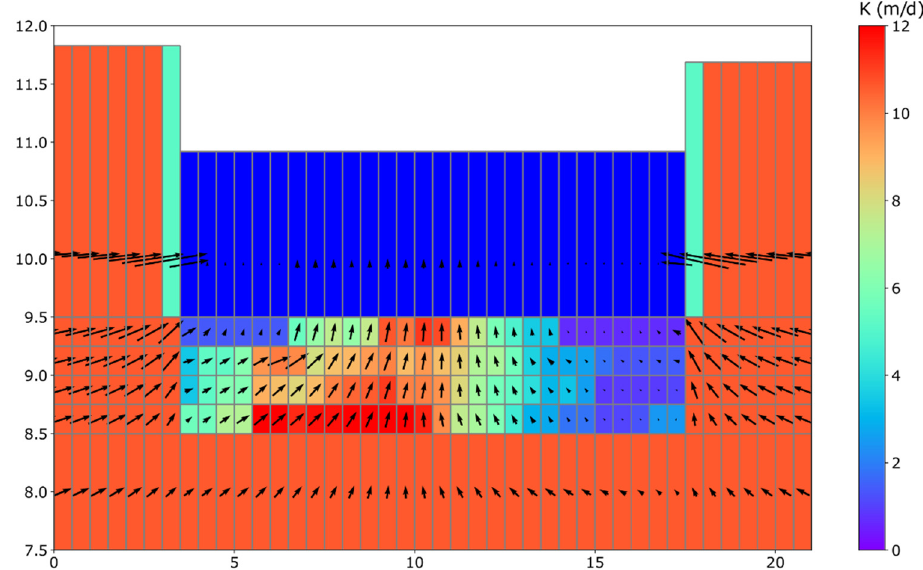
Figure 10. Cross section through the riverbed at Y = 10 m at the upstream section. Arrows indicate the direction and magnitude of groundwater flow through the aquifer and riverbed. Colour fill visualises the hydraulic conductivity of the riverbed, riverbank, and aquifer. Dark blue indicates constant head cells (i.e., the river water). Only the top six model layers are visualised.